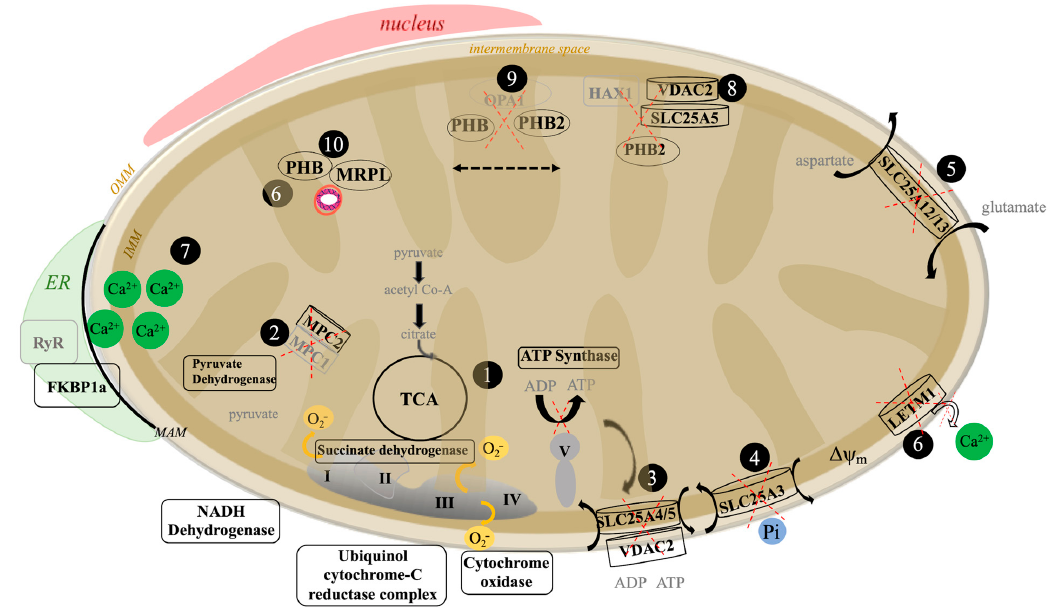
Figure 8. A model of mitochondrial disruption by A β 42 based on our proteomic findings of specifically altered mitochondrial proteins ( bold ). 1: bioenergetics (TCA and ETC); 2: pyruvate dehydrogenase complex; 3: ATP/ADP exchange; 4: inorganic phosphate carrier; 5: glutamate/aspartate carrier; 6: LETM1 calcium transport; 7: FKBP1a stems calcium influx from ER; 8: anti-apoptotic HAX1 factor localized to the inter-membrane space through interaction with PHB2. 9: OPA-prohibitin complex stabilizes cristae; and 10: nucleoid stabilized to the IMM by